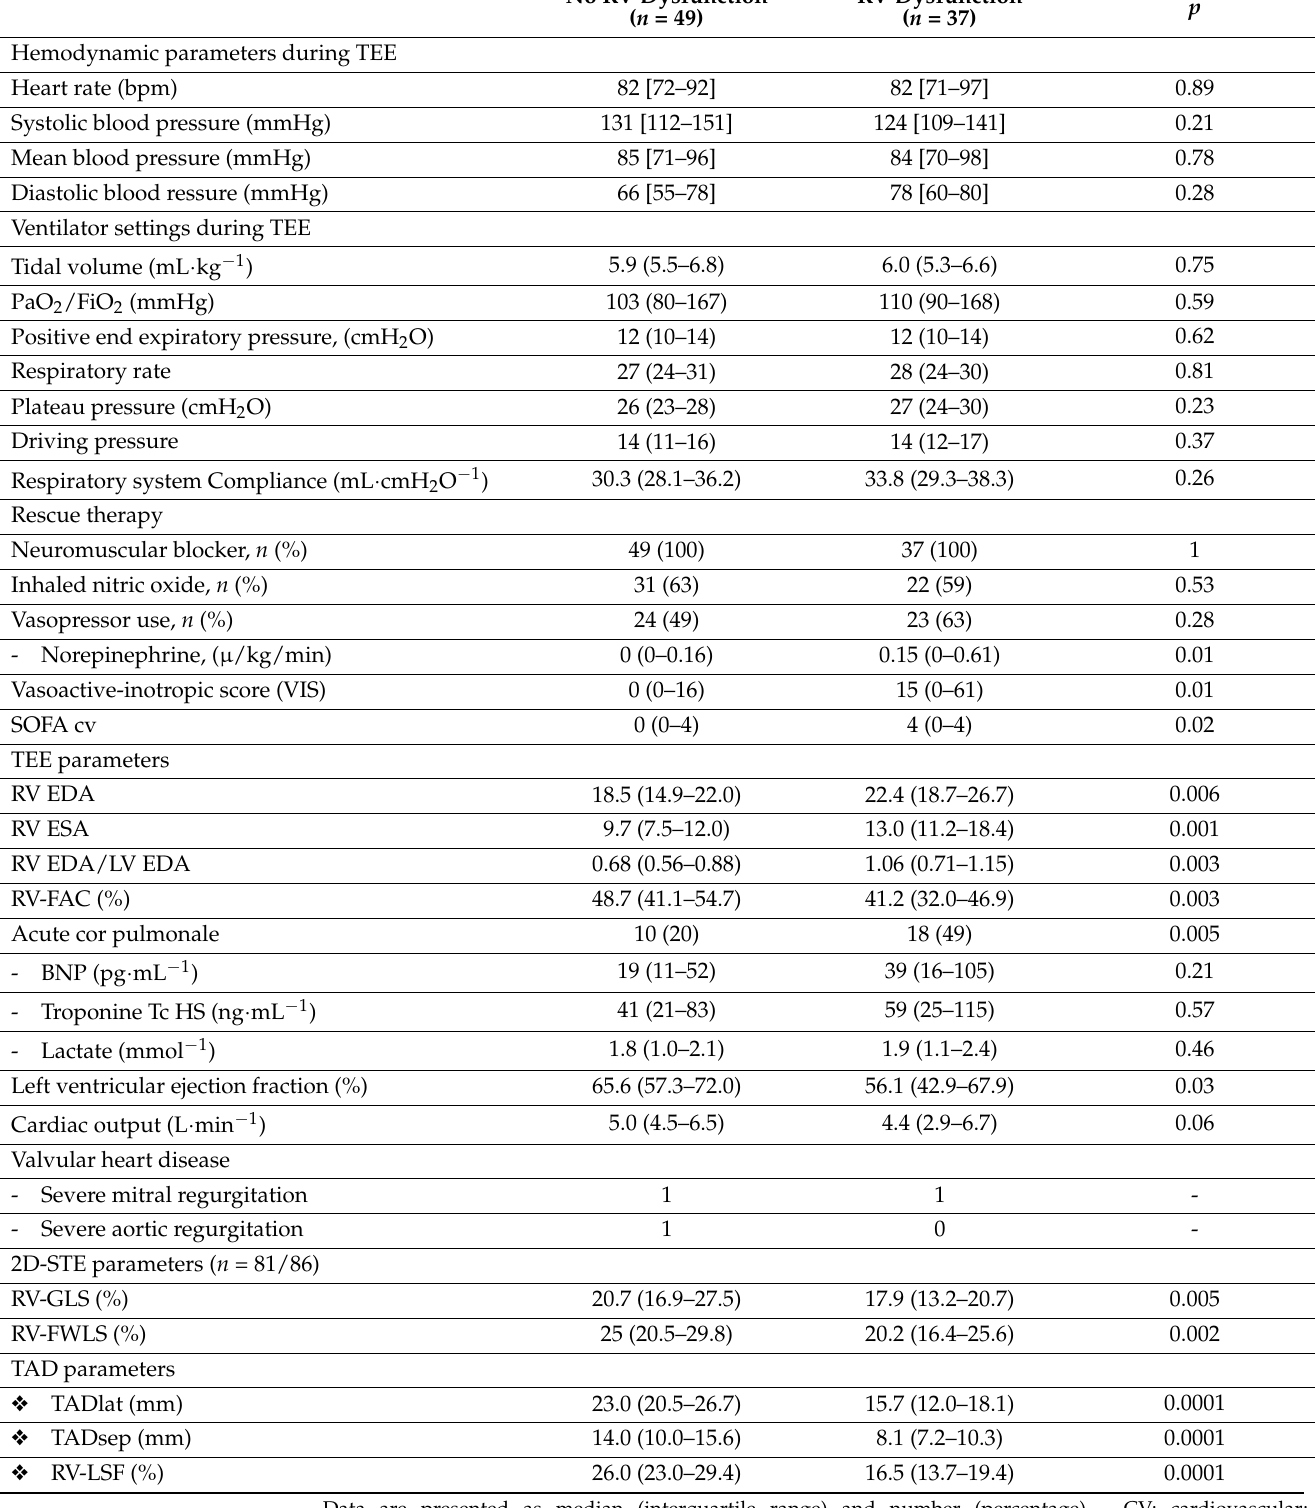
Table 2. Hemodynamic, ventilatory and echocardiographic